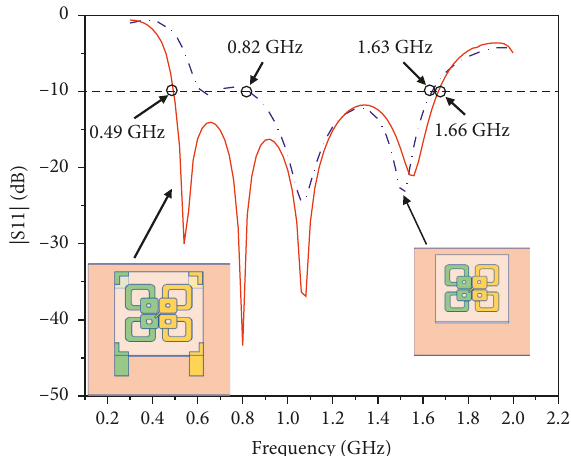
Figure 2: Simulated S-parameters of the antenna with/without parasitic elements.